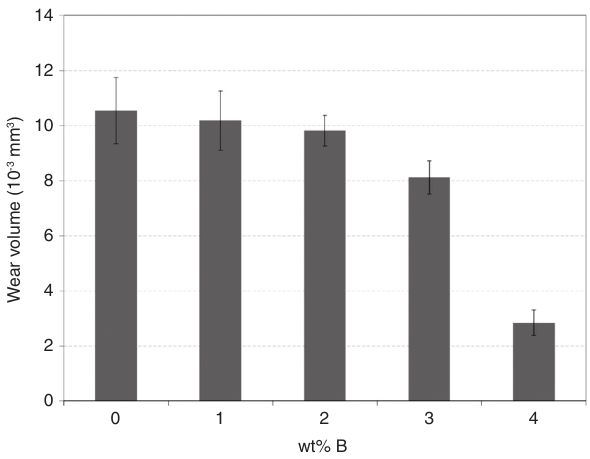
Figure 3 Wear volume measured using optical profilometry as a function of boron percent.